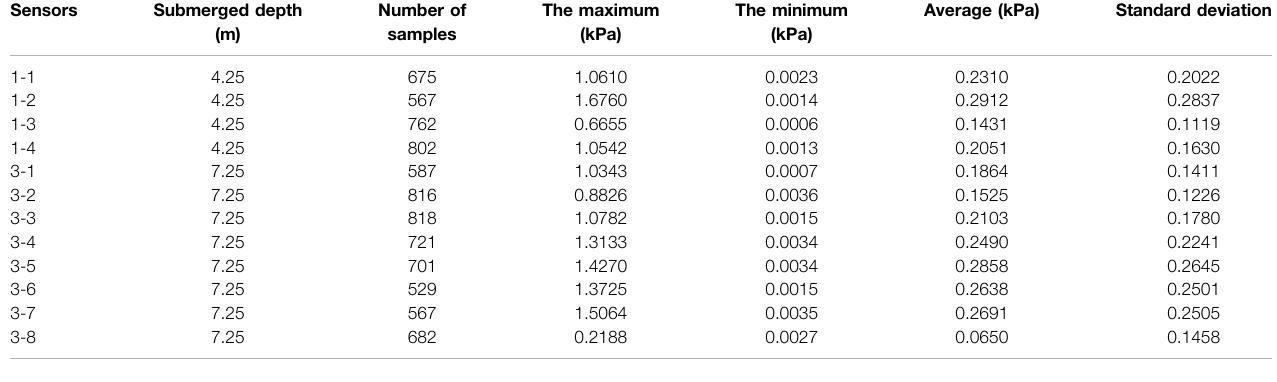
TABLE 2 | The eigenvalues of the hydrodynamic pressure.